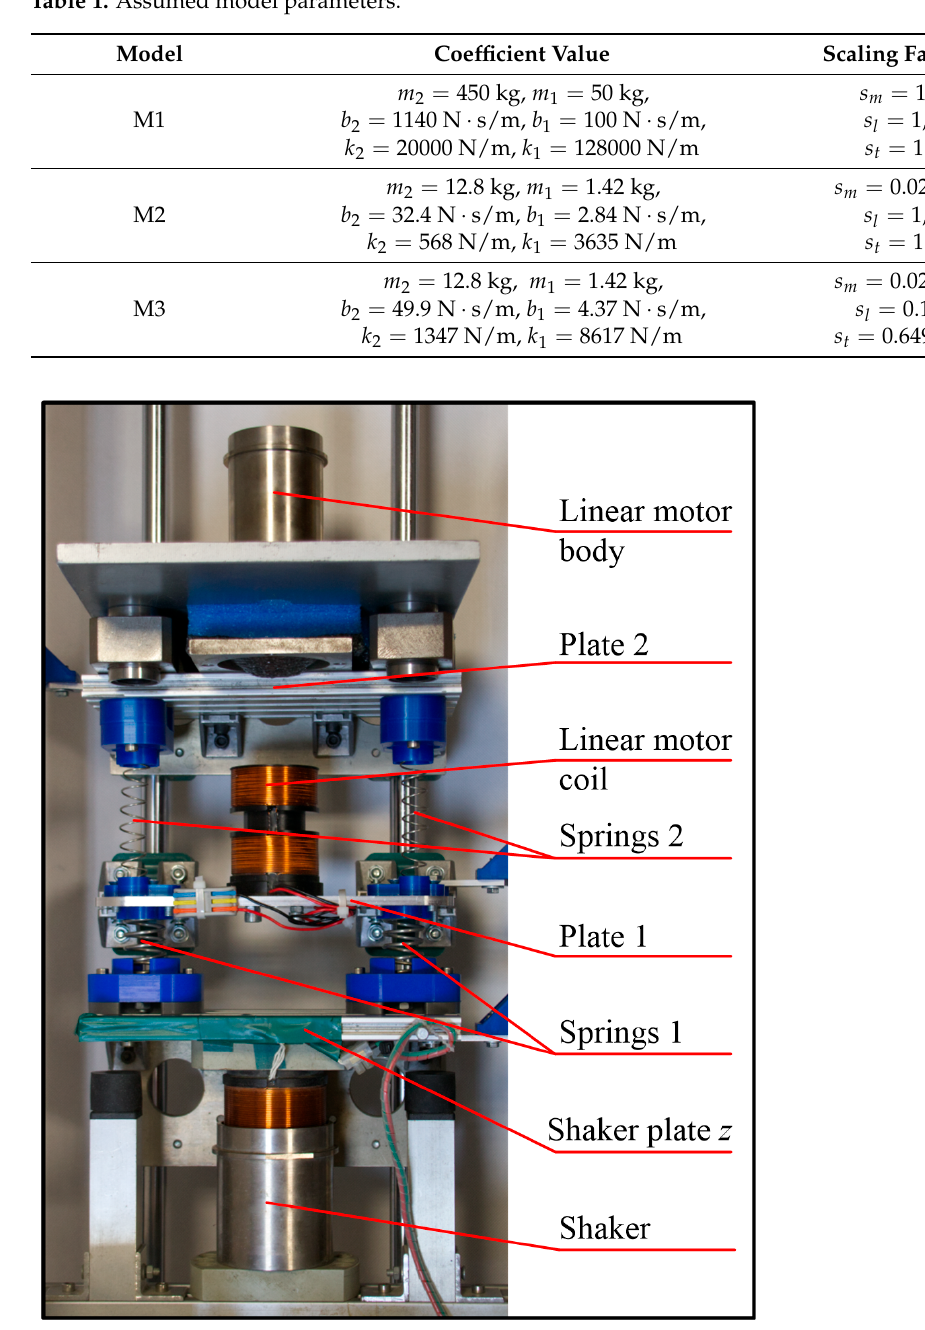
Figure 2. Laboratory implementation of the PVRS.